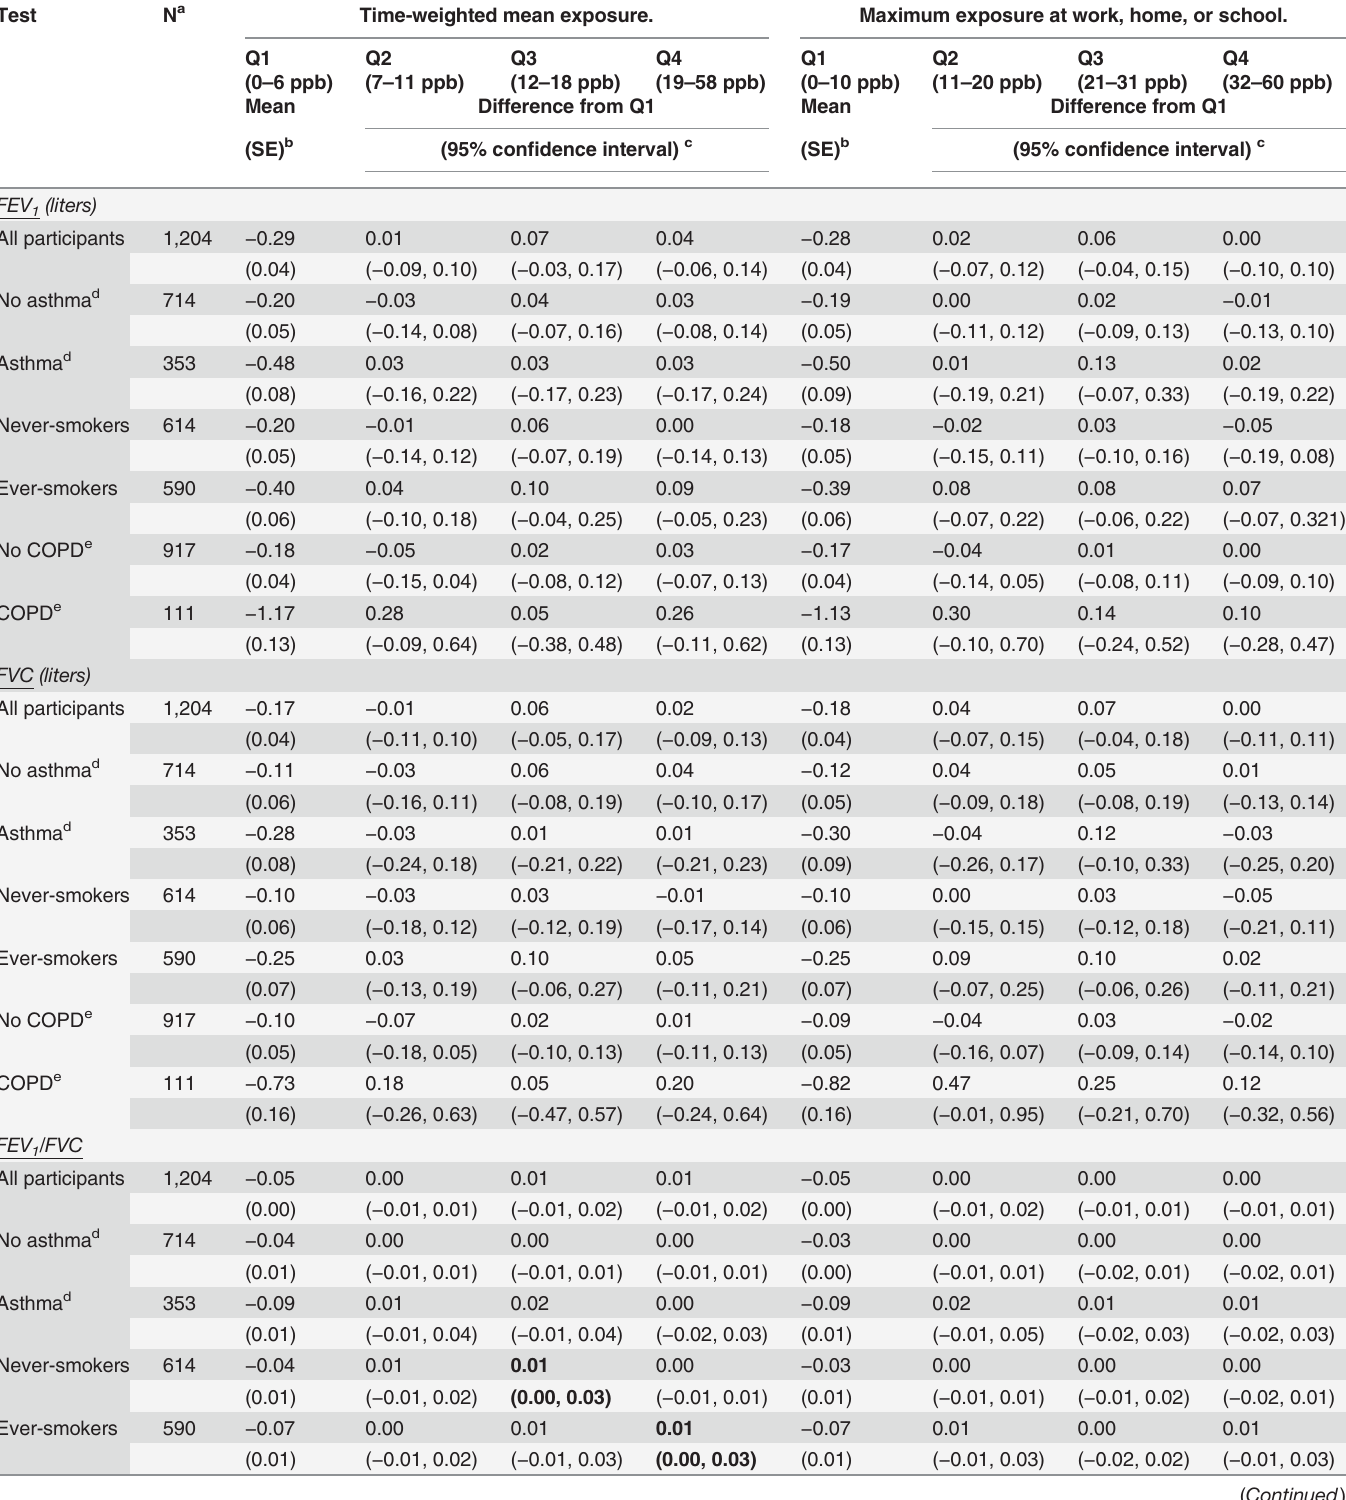
Table 2. Linear regressions of differences between observed and expected spirometric parameters (pre-bronchodilator spirometry results), show- ing adjusted differences from the first quartile (Q) of long-term (30 year) H 2 S exposure concentration in ppb, after controlling for covariates. Test N a Time-weighted mean